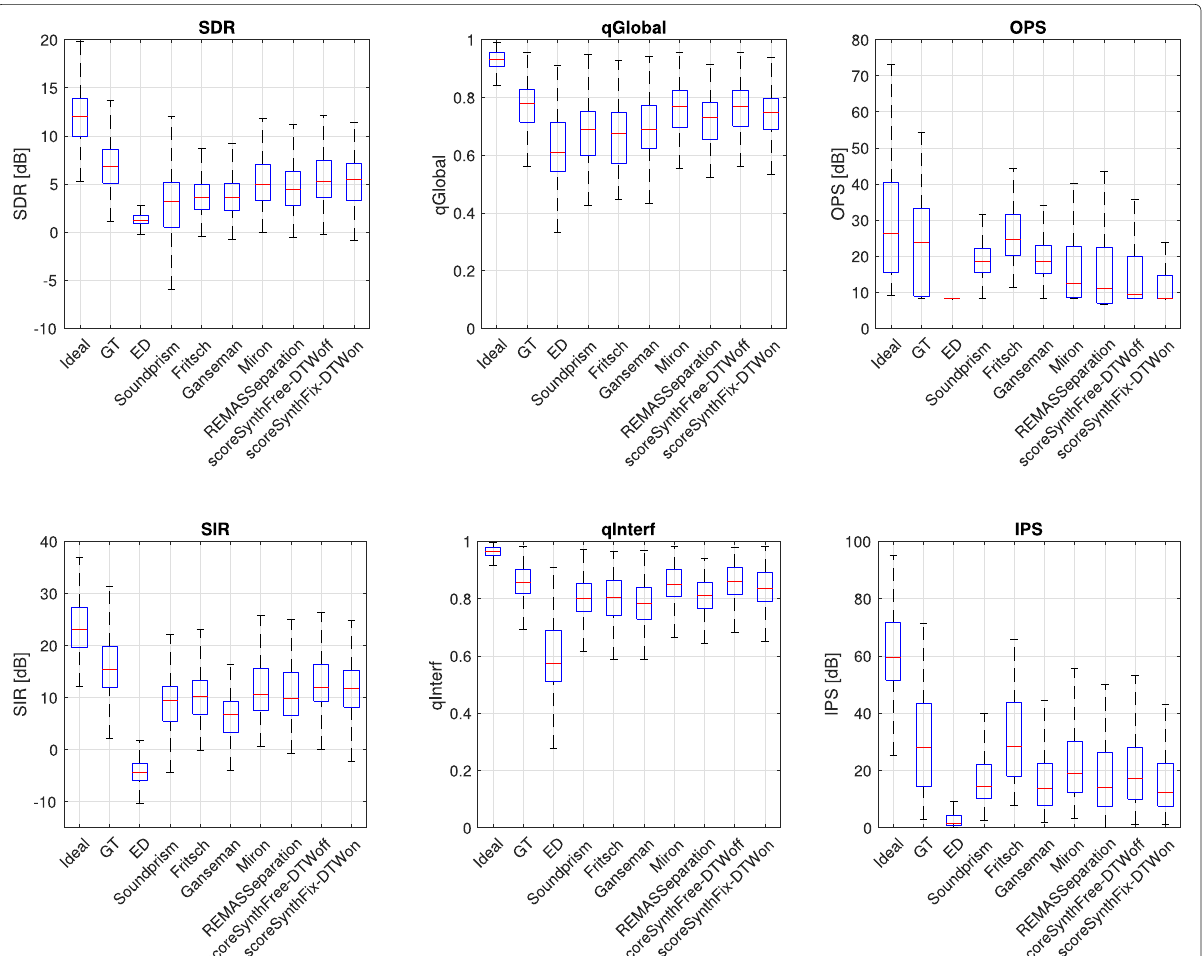
Fig. 7 Objective and perceptual results for the comparison of the SS methods using the BBS_EVAL metrics and the PEASS metrics for the URMP